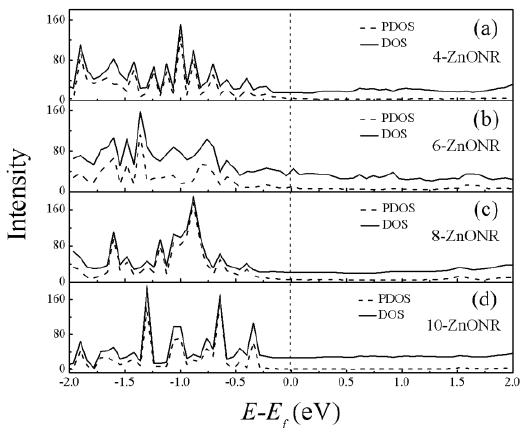
4 of 9 Figure 2. Transmission spectrum of the n -ZnONR (( a ): n = 4, ( b ): n = 6, ( c ): n = 8, ( d ): n = 10) device at equilibrium, and the zero of the energy is set to Fermi level. Then, we considered the influence of the interface between the Au electrode and the ZnO nanorod. Figure 3 shows the density of states (DOS) of the scattering regions, including the ZnO nanorod and 96 Au atoms that were evenly distributed at both ends of the nanorod, and the projected density of states (PDOS) of the ZnO nanorod, including only O and Zn atoms for n -ZnONR ( n = 4, 6, 8, 10) devices at equilibrium. It can be observed that the shapes of the DOS of the scattering regions were similar to the PDOS of the ZnO nanorod. However, the DOS of the scattering region near Fermi level was higher than the PDOS of the ZnO nanorod, which means that the transmission spectrum near the Fermi level of the device was mainly contributed to by the interface state rather than the central ZnO nanorod. For the 4-ZnONR device, the interface states of the two terminals of the ZnO nanorod will overlap and form a transmission channel near Fermi level. Electrons can travel from the